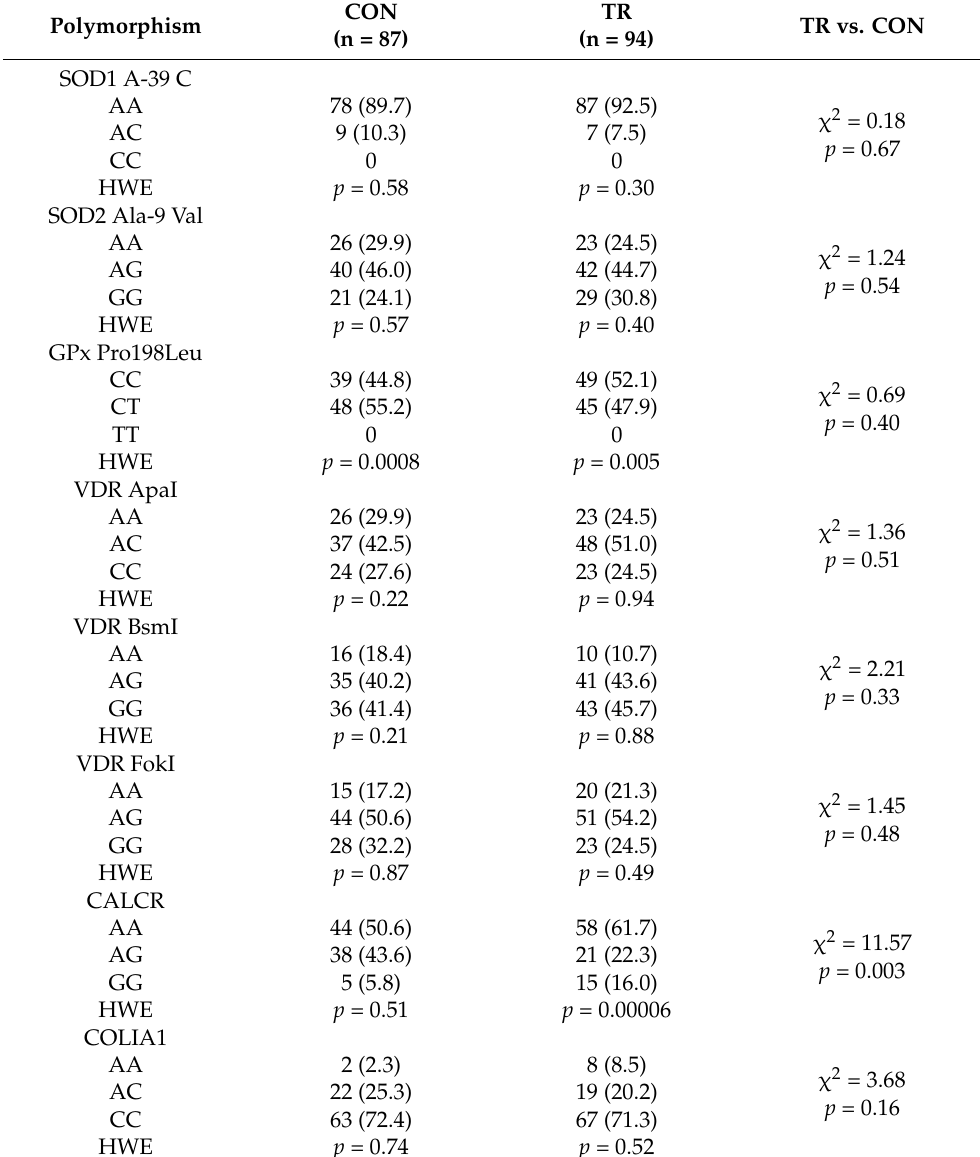
Table 3. The distribution of genotypes for gene polymorphisms in the control group (CON) and in the trained group (TR) (n